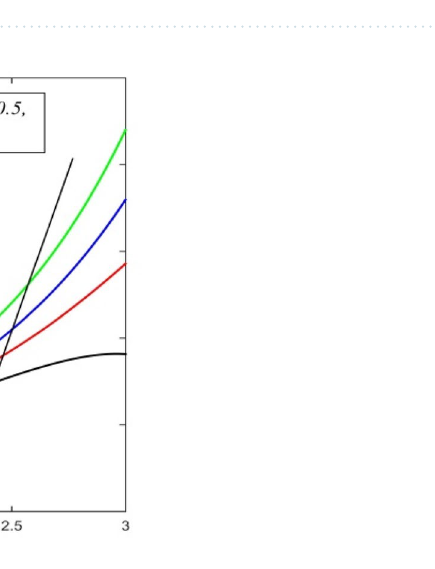
Figure 33. τ versus t for different Sc and K = 2, N = 3, Pr = 0.71, M = 0.5, Du = 0.5, K* = 3, Gr = 1, Gm = 5, a = 1, t 1 = 0.5.